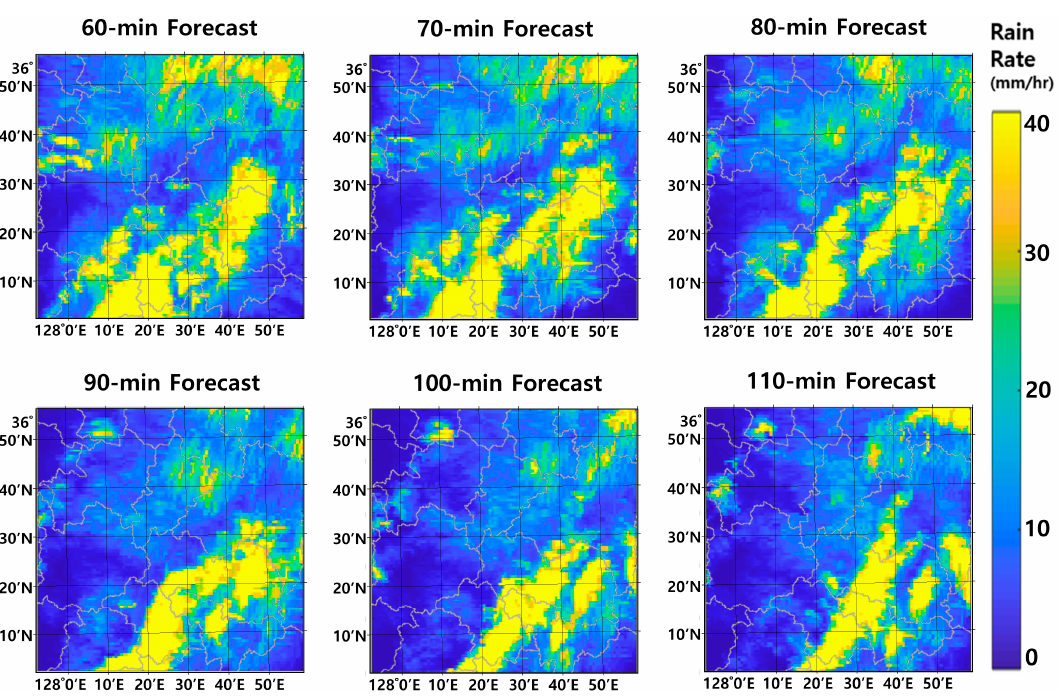
Table 2. Weights to be used to make the ensemble forecast with six ensemble members. Forecasting Time No.